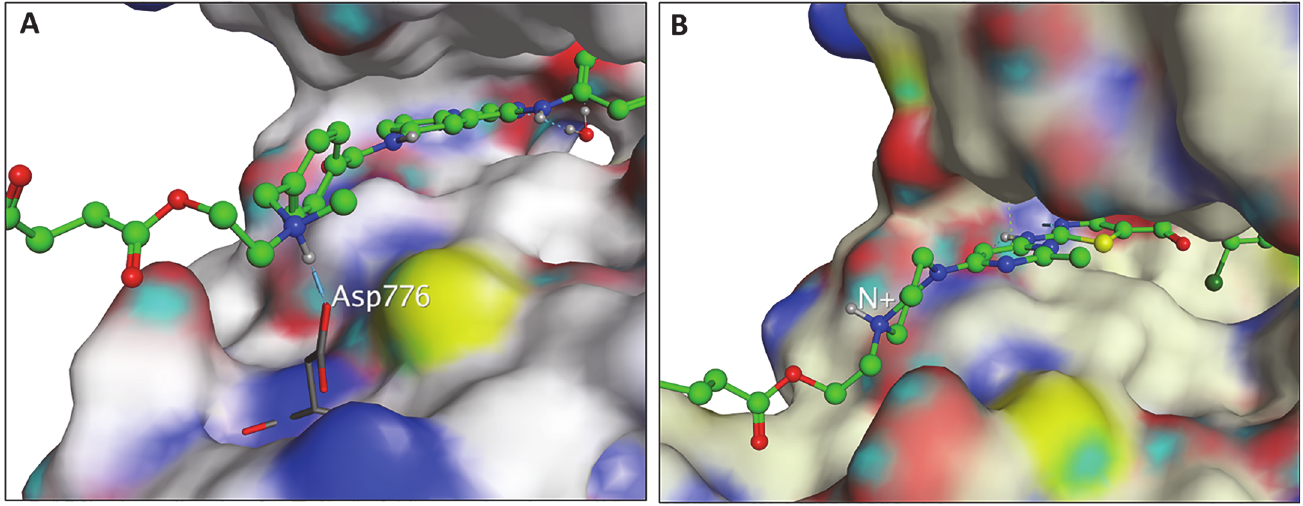
Fig 6. Molecular modeling of AL776. ( A ) AL776 modeled in the EGFR kinase-binding pocket using the Protein Data Bank (PDB) with code 1M17. The quinazoline moiety can bind to the hinge region in a manner analogous to erlotinib, while the linker-dasatinib portion of AL776, exposed to solvent, can adopt a number of conformations. The protonated form of the tertiary amine in AL776 can interact with Asp776. ( B ) AL776 modeled in the c-Src pocket using the PDB with code 3G5D. The dasatinib moiety of AL776 binds to the hinge portion of the c-Src ATP binding pocket in a pose identical to dasatinib while the linker-quinazoline portion of AL776 points out into solvent and can adopt many